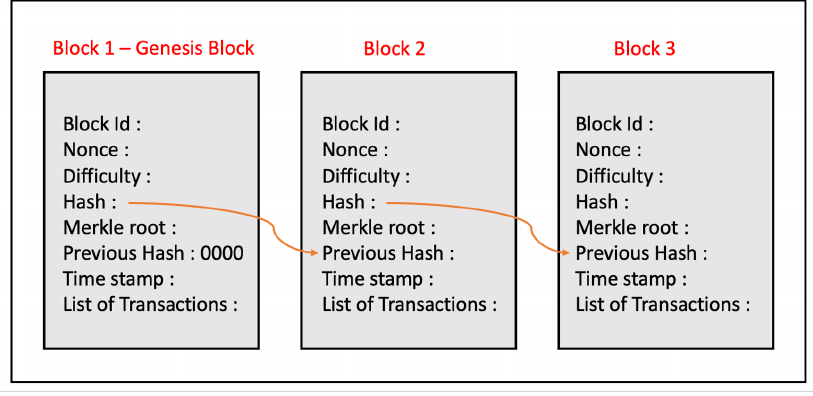
Figure 5. Blockchain